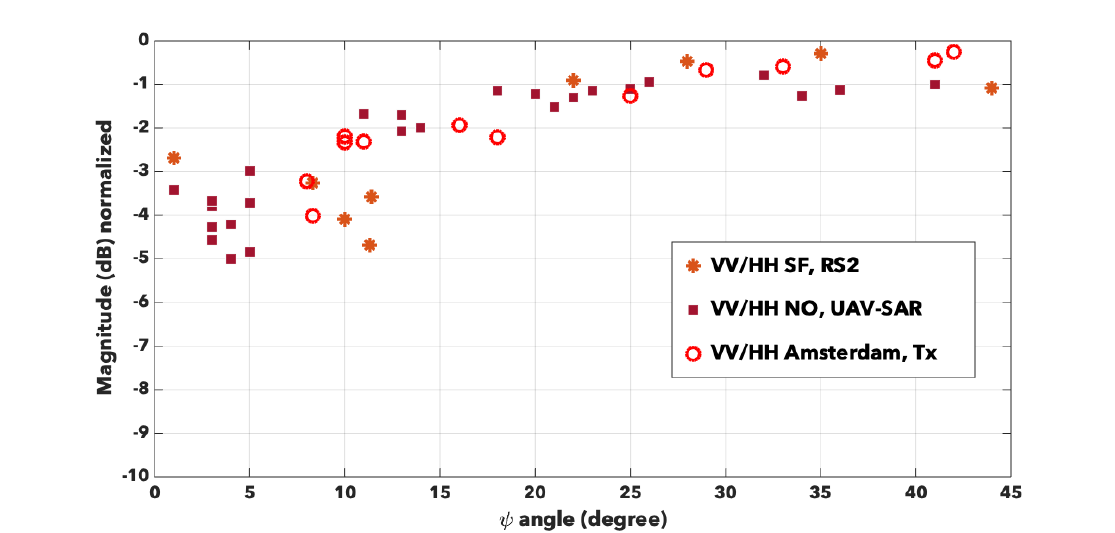
Figure 9. Variation of the co-pol ratio with the orientation angle for San Francisco (stars), New Orleans (full squares) and Amsterdam (empty